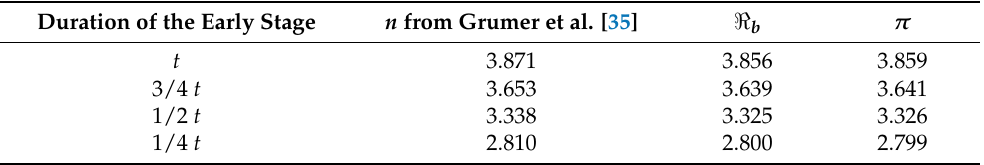
Table 5. Dimensionless flame radius and relative pressure of stoichiometric CH 4 -N 2 O mixture diluted with 60 vol% N 2 , at ambient initial temperature and p 0 = 1.25 bar. Duration of the Early